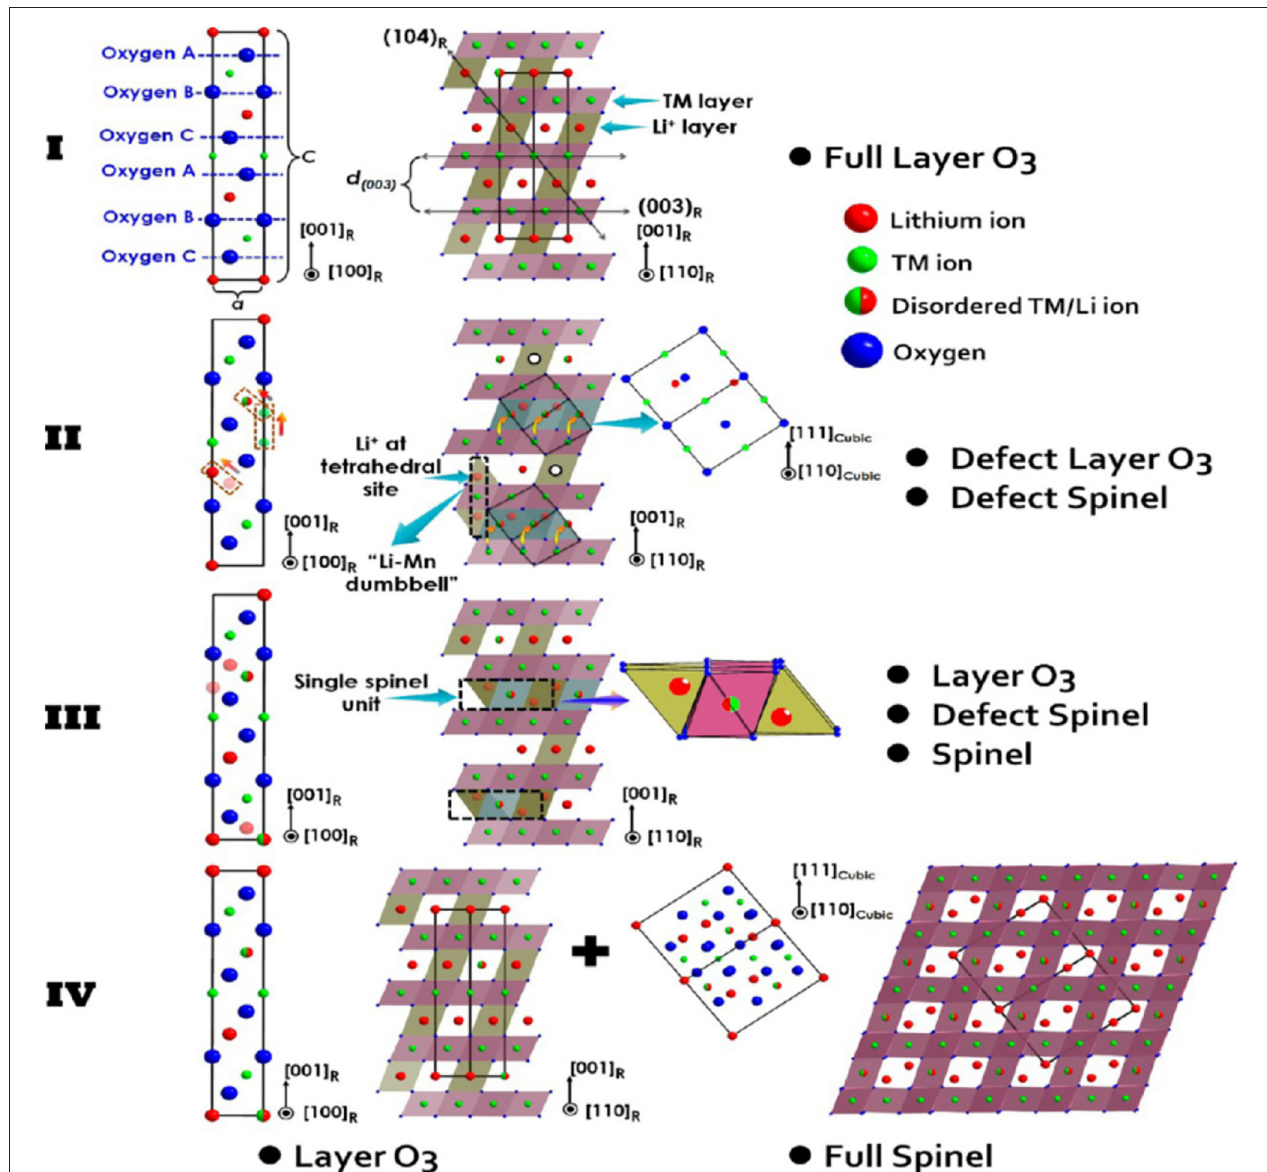
FIGURE 1 | High-nickel cathode material in four-stage microstructure of the atomic distribution and order of the schematic explanation.